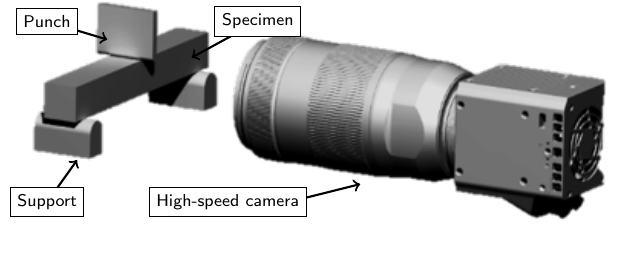
Figure 5. Test setup for a 3-point-bending experiment with high-speed imaging. The camera is oriented orthogonal to the specimen’s